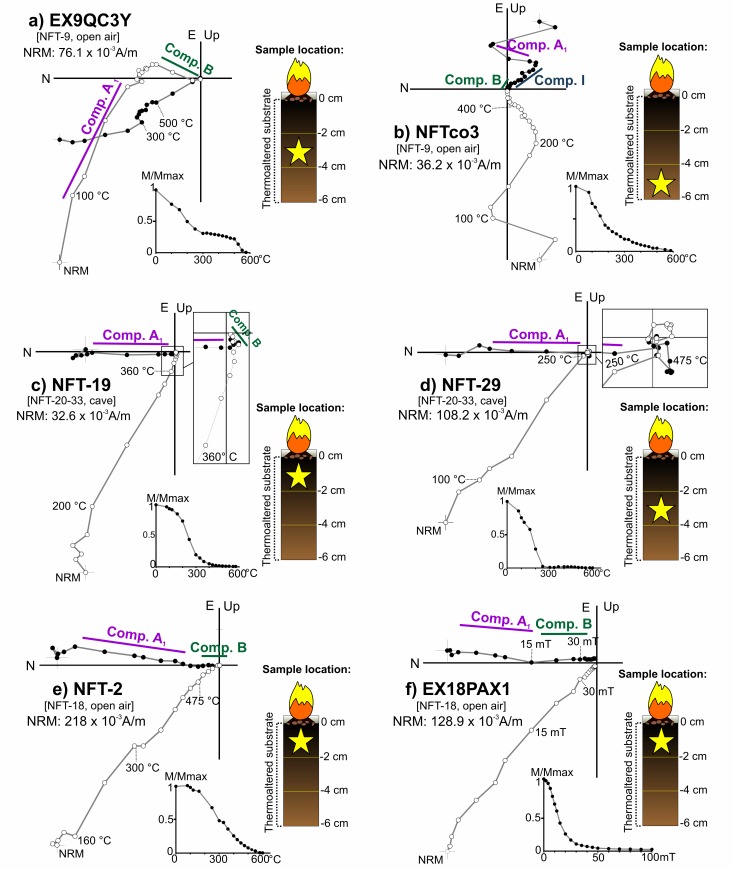
Representative orthogonal NRM thermal and alternating field demagnetizations plots of samples showing component A1.Stratigraphic location of each sample with respect to the surface is indicated for each panel. For clarity, the higher temperature steps of panels C and D are blown-up showing the presence of high-temperature components. Symbols as in Fig 7.